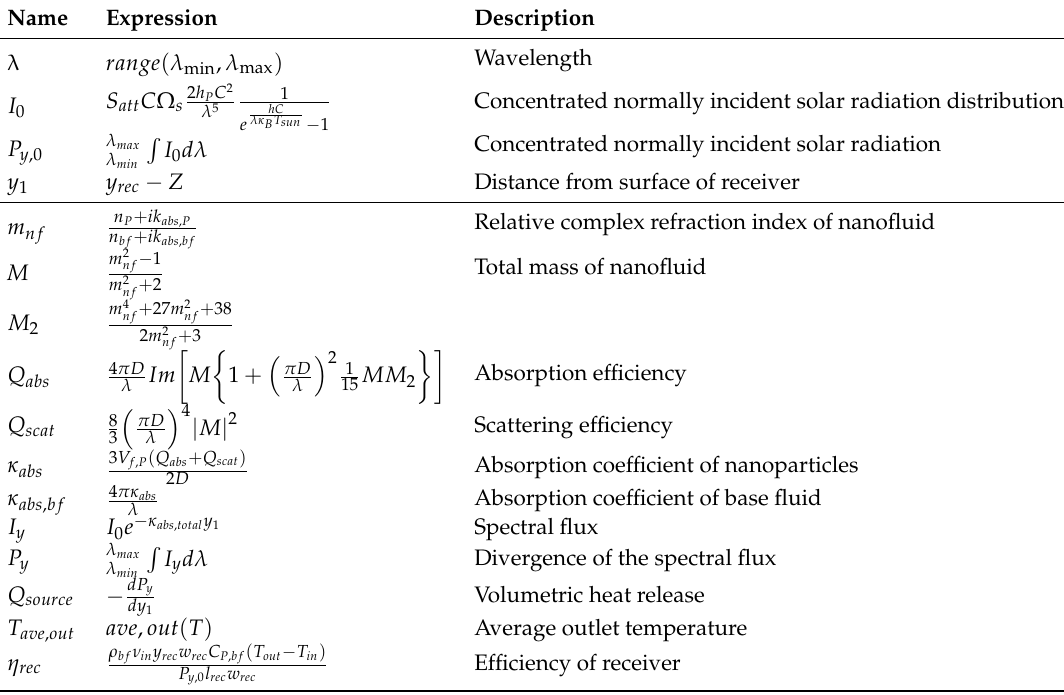
Table 2. Variables used in the computational